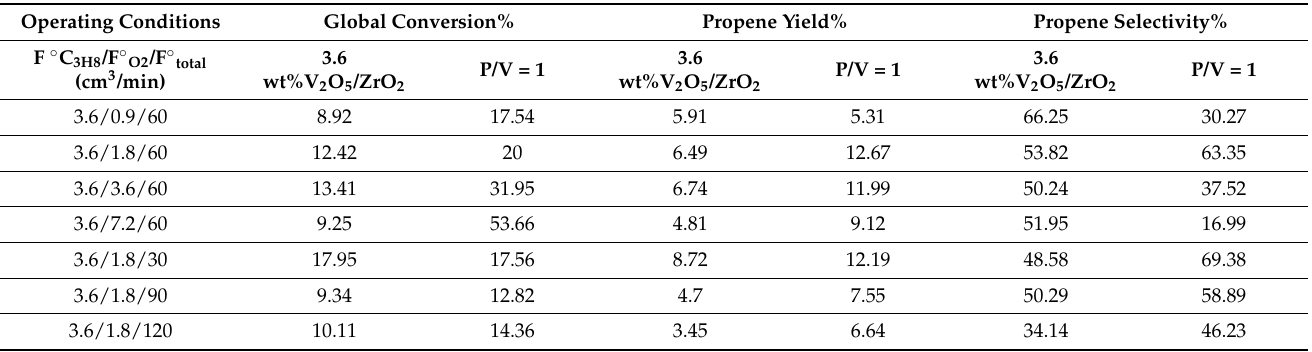
Table 2. Comparison of activity and selectivity to propene at 500 °C of 3.6wt%V 2 O 5 /ZrO 2 and at P/V = 1 catalyst depending on the reaction mixture.